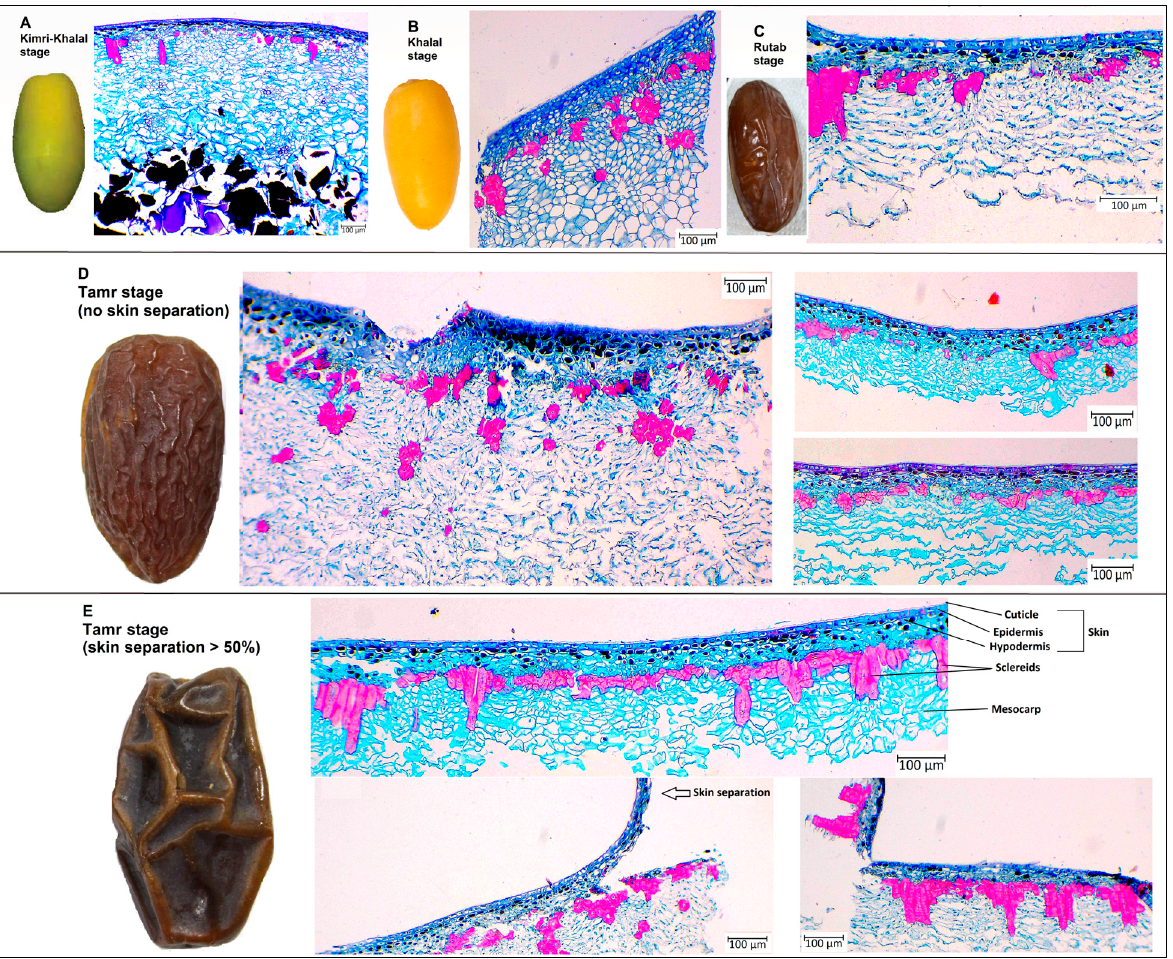
Figure 2. Date palm fruit anatomy at ( A ) Kimri-Khalal, ( B ) Khalal, ( C ) Rutab, and ( D ) Tamr with no skin separation and ( E ) with skin separation >30%.